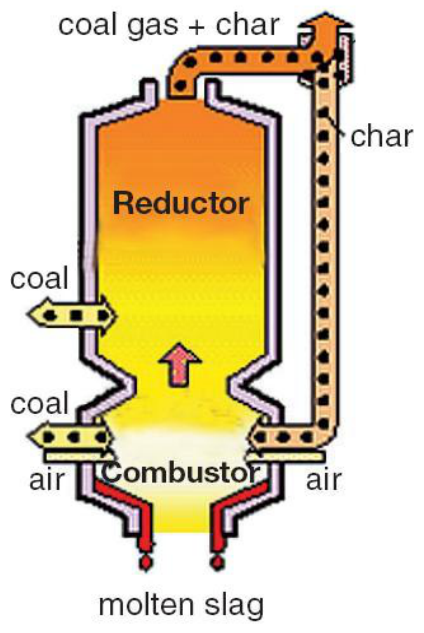
Figure 14. MHI Gasifer